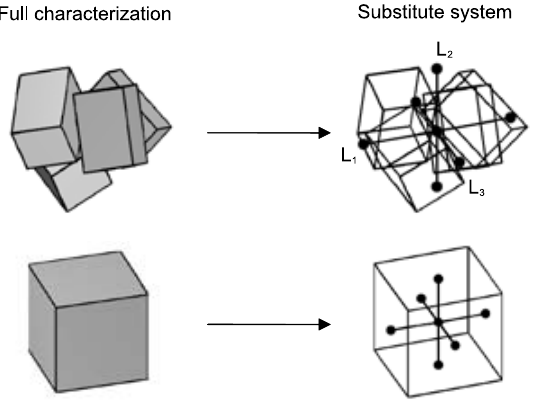
Fig. 1 Full and substitute characterization for an aggregated and a pri- mary